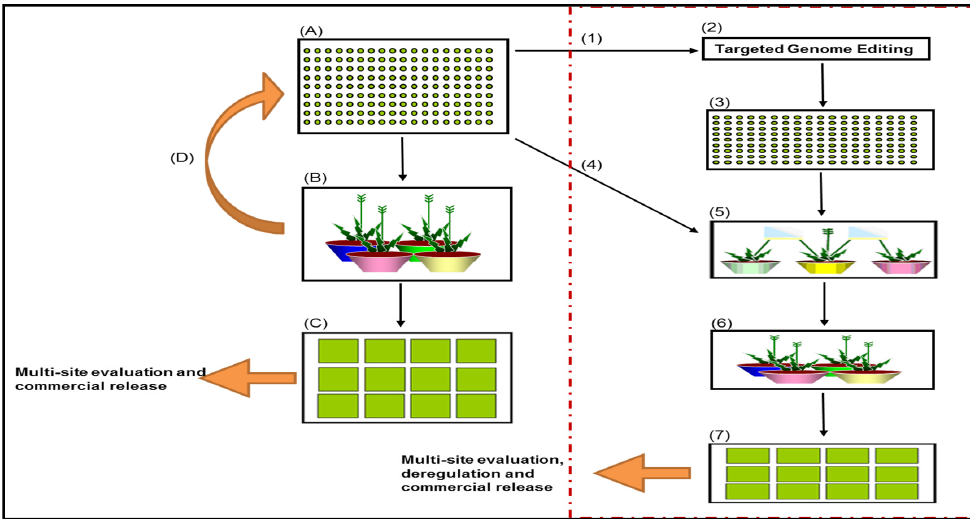
Figure 1. An optimum breeding strategy for transgenic Lolium grasses based on a genomic selection approach described by Hayes et al. Sections ( A – D ) are the phases of the genomic selection schema as proposed by Hayes et al. Sections 1 – 7 relate to the transgenic breeding strategy defined in this paper.